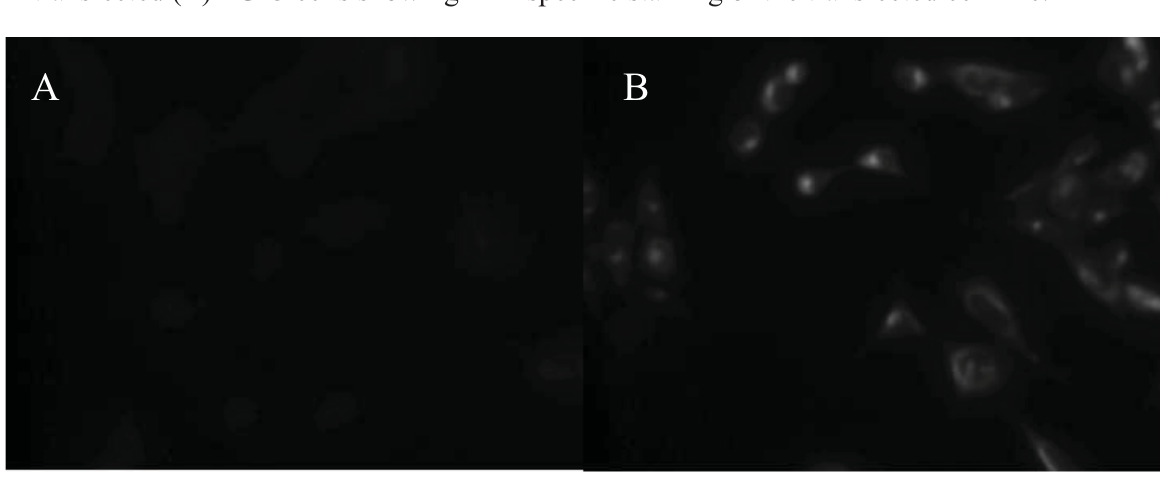
Figure 3. Immunofluorescence staining of paired untransfected ( A ) and human IL-4